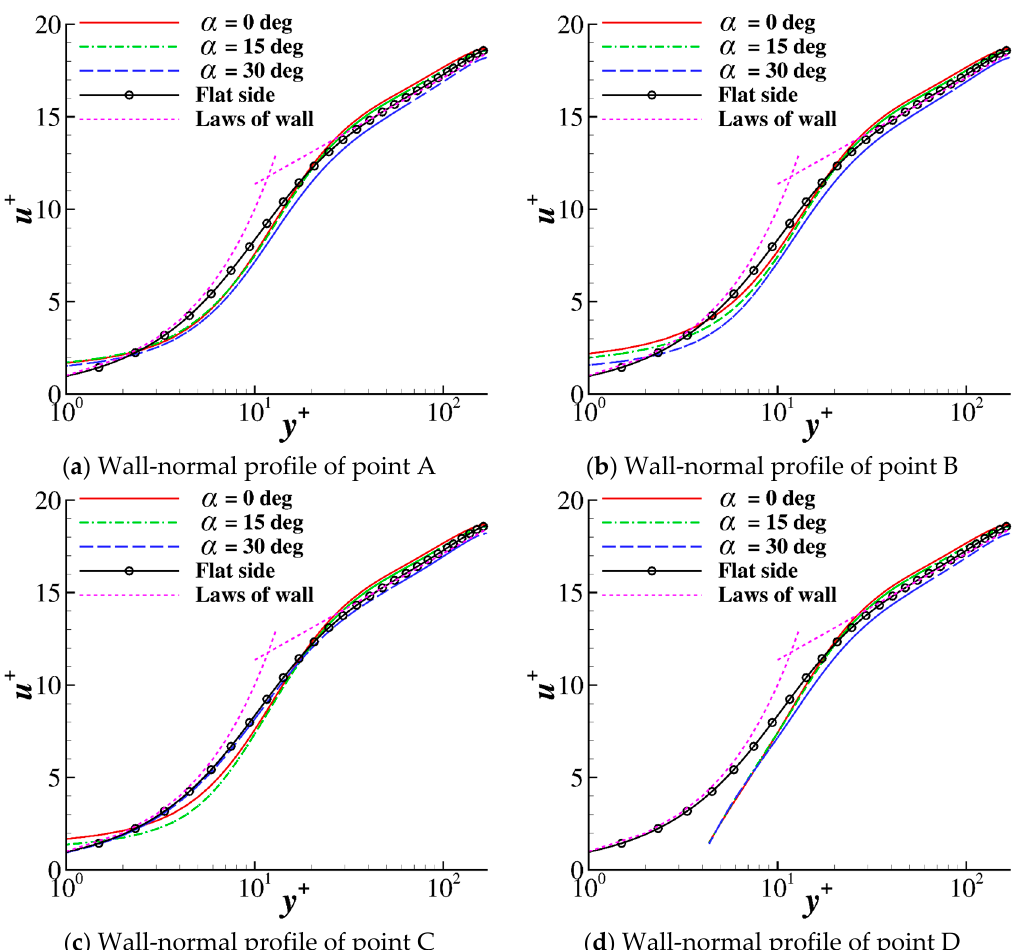
Figure 4. Mean streamwise velocity distributions at several wall-normal profile lines. Energies 2019 , 12 , x FOR PEER REVIEW